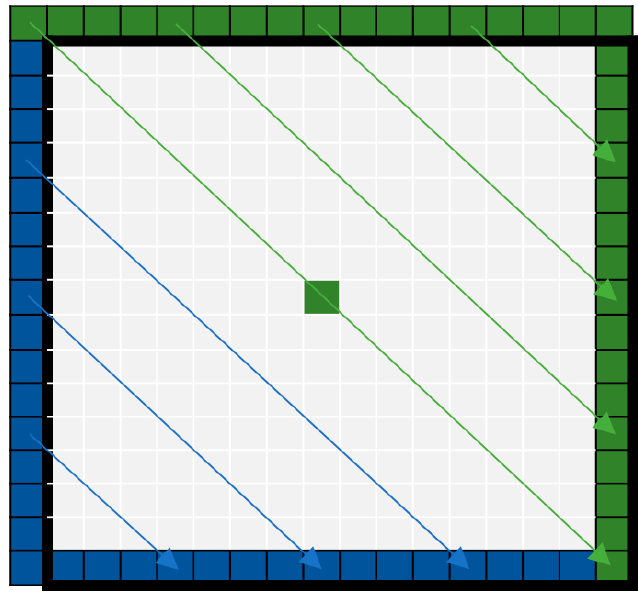
Figure 6. Partial intra prediction for a 16 × 16 block (diagonal mode).